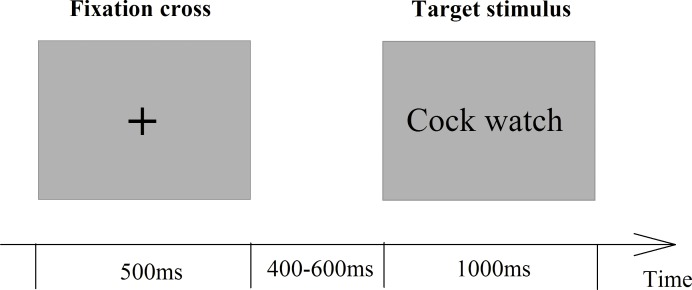
Experimental procedure.The participants were presented with four brand-product strategies [CN, CF, NN and NF]. They were instructed to complete the brand-product evaluation tasks and had a maximum of 1500 ms to make each choice. EEGs of the subjects were recorded throughout the experiment.